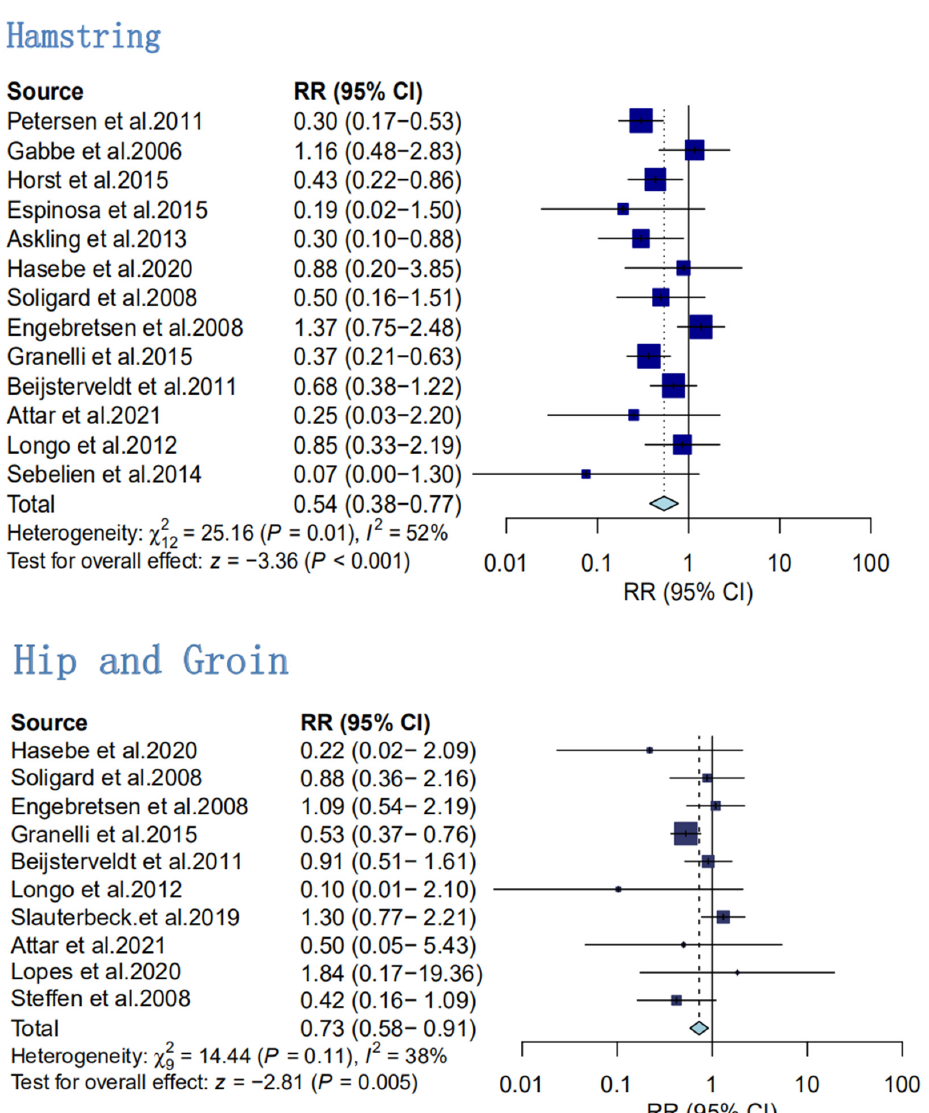
Figure 5. Secondary analyses of injury rates in hamstring eccentric exercise prevention programs, compared with control intervention for the following specific body regions: hamstring and hip and groin